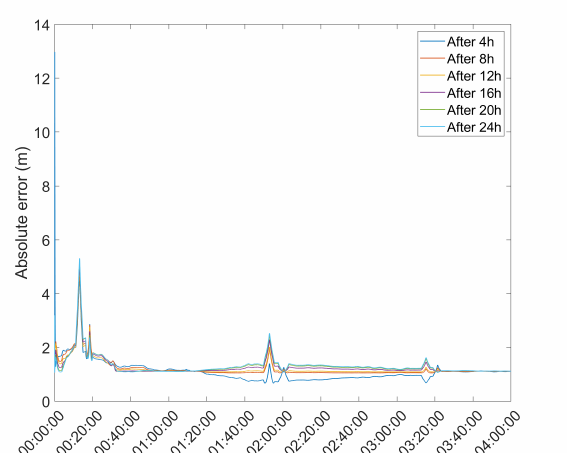
Figure 13. Rover position error with base station position obtained with UKF and averaged after a set number of